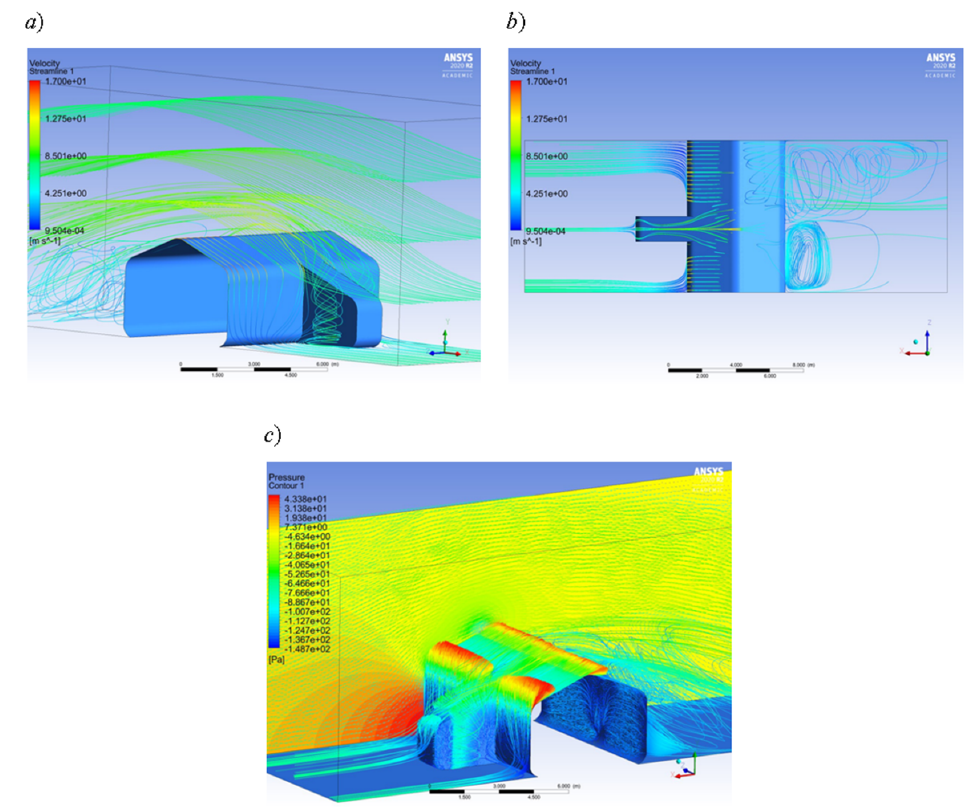
Figure 4. Distribution of air flow velocity, m/s ( a , b ) and pressure, Pa ( c ) on the surface of the model of the house when flowing undisturbed air flow at the angle of attack α = 0°.